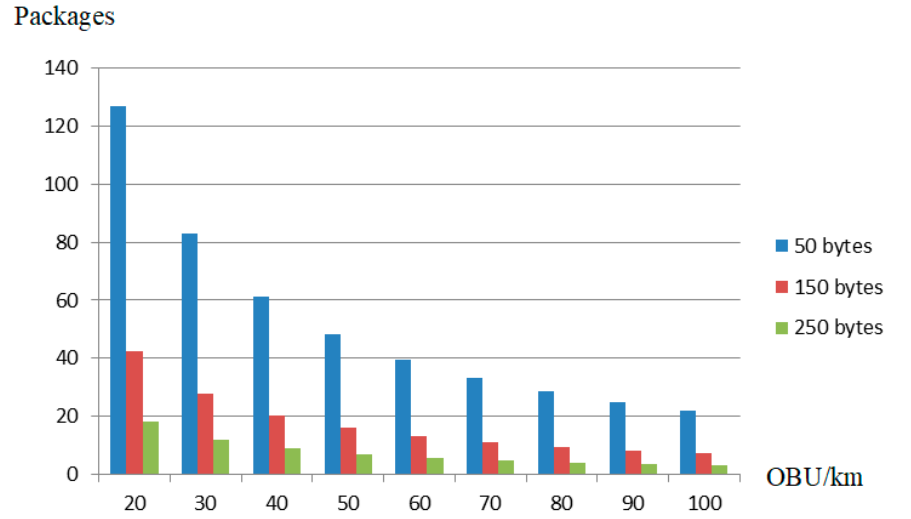
Figure 5. Dependence of the average number of packets per OBU on road traffic intensity with maximal level of confidentiality and a 64-bit protocol.